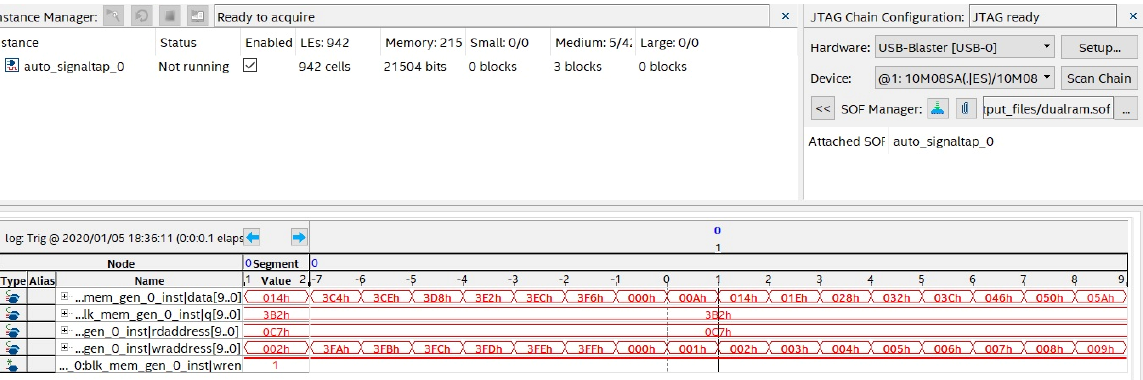
Figure 20. Signal Tap Logic Analyzer window displaying simple dual-port RAM process.